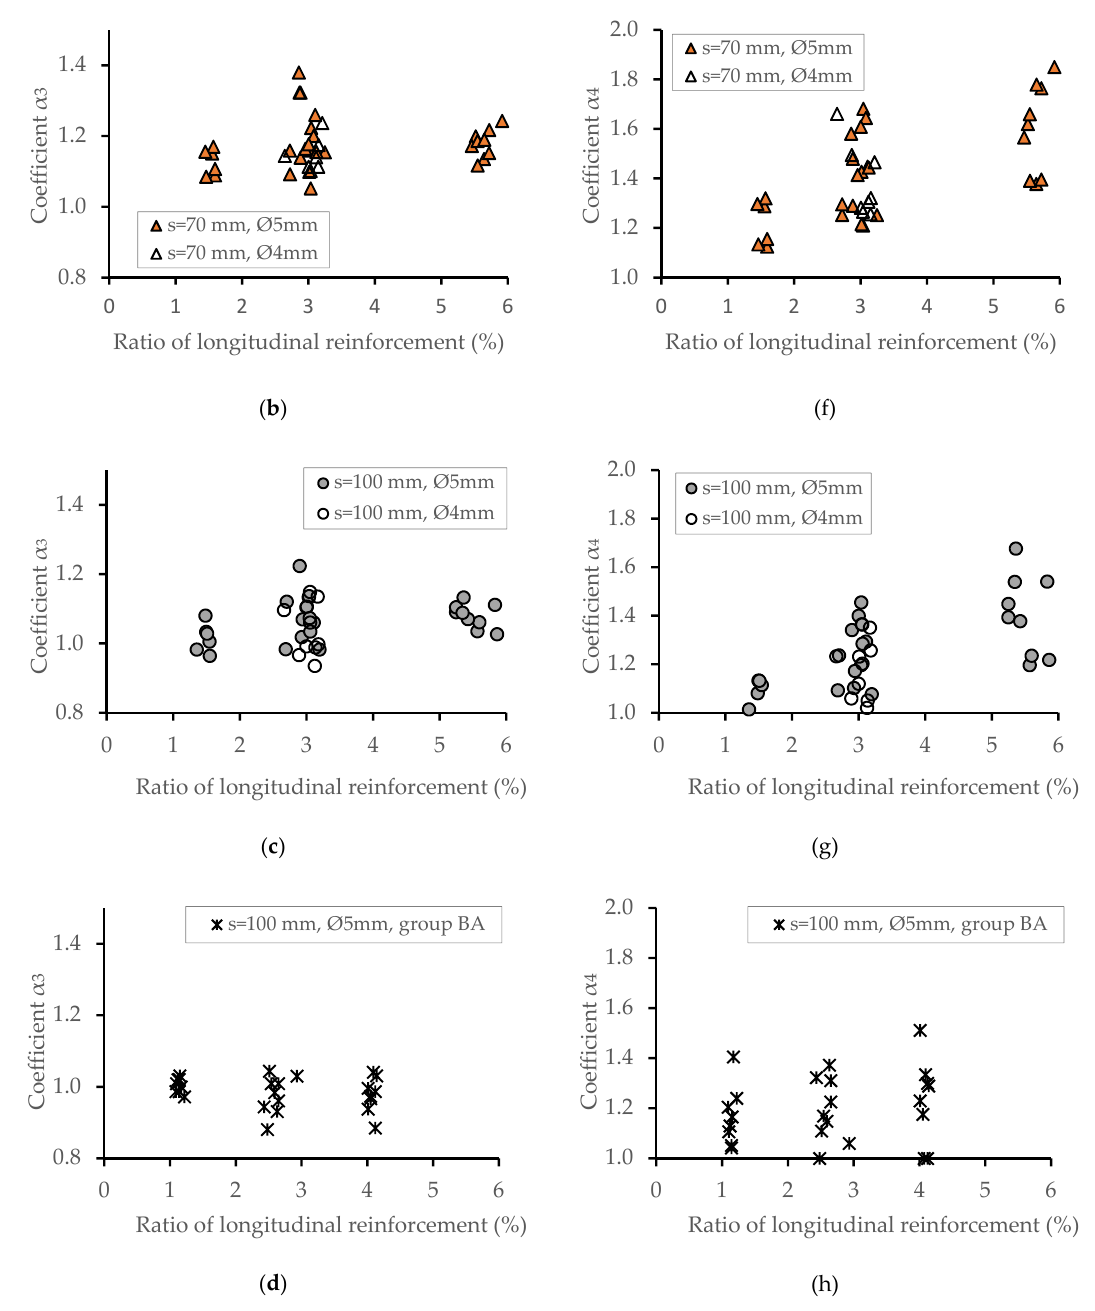
Figure 8. Coe ffi cients α 3 ( a , b , c , d ) and α 4 ( e , f , g , h ) dependence on the ratio of longitudinal reinforcement µ ff erent pitch of transverse Figure 8. Coefficients α 3 (a,b,c,d) and α 4 (e,f,g,h) dependence on the ratio of longitudinal 456 s by di reinforcement µ s by different pitch of transverse reinforcement. 457